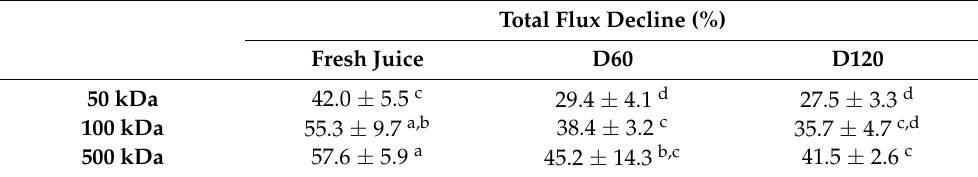
Table 2. Total flux decline (%) of fresh and depectinized (D60 and D120) cranberry juices after UF with membrane MWCO of 50, 100 and 500